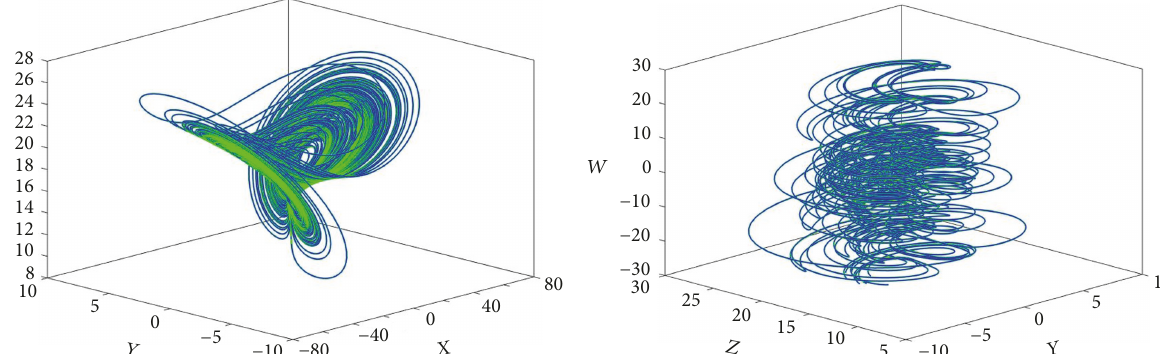
Figure 2: 3D phase portraits of NCS 2 system.